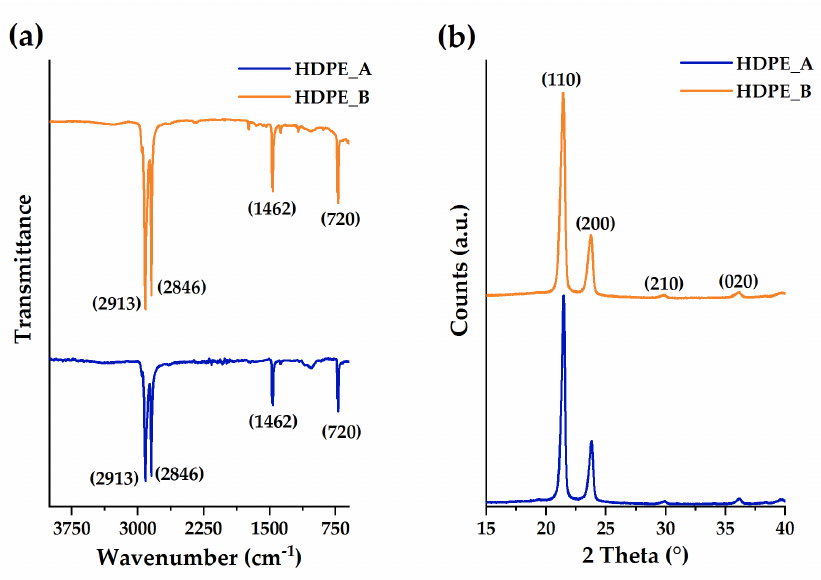
Figure 5. ( a ) ATR-FTIR spectra; and ( b ) XRD patterns of microbeads extracted from A and B commercially available facial scrubs.